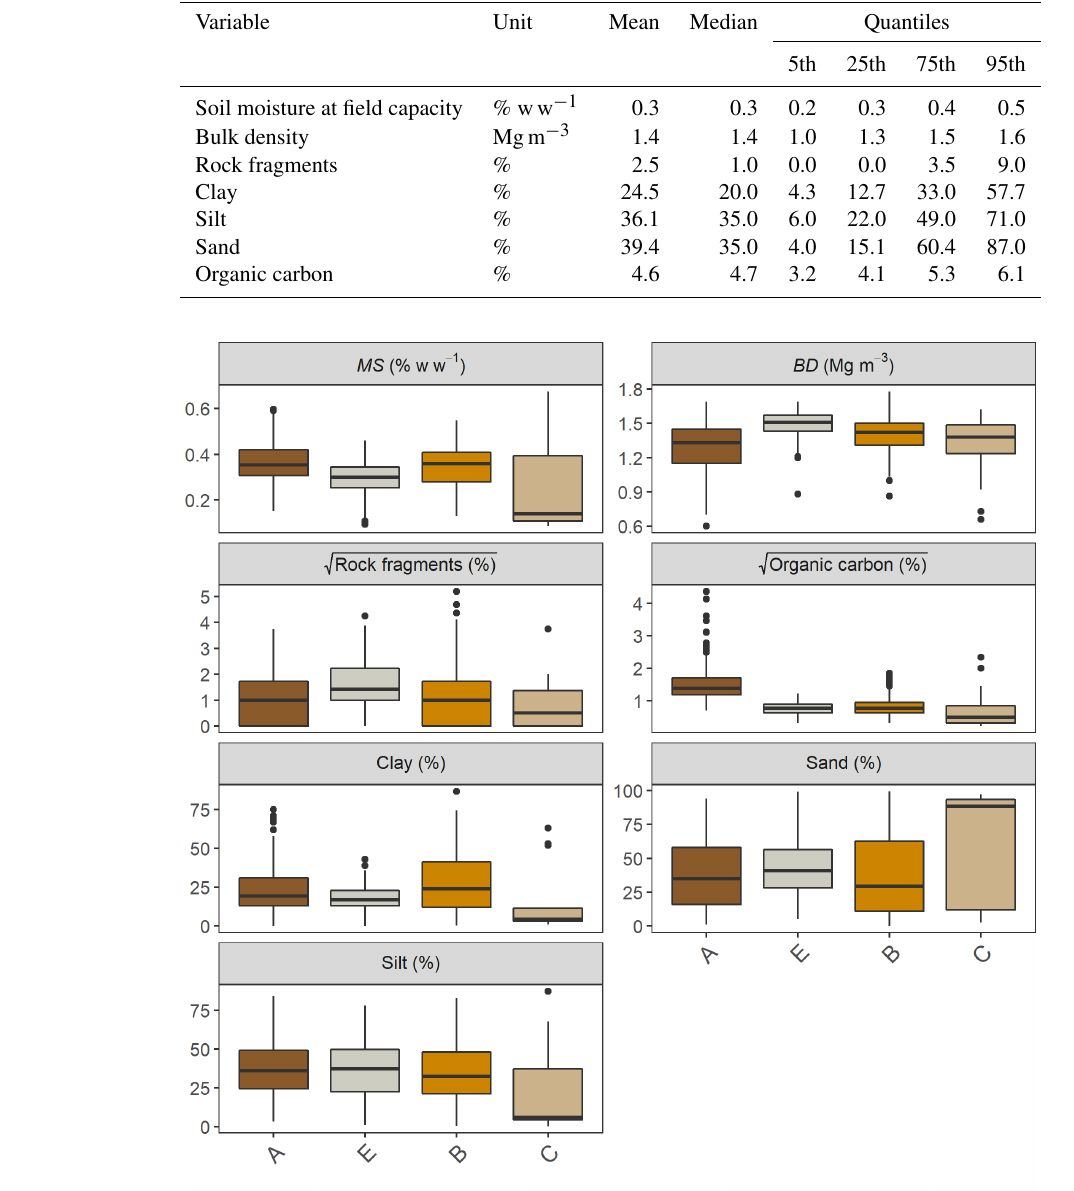
Table 1. Descriptive statistics of the soil properties from the 265 agricultural soil profiles (depths between 0.22 and 1.96m) from the LandIS database used in the simulations.